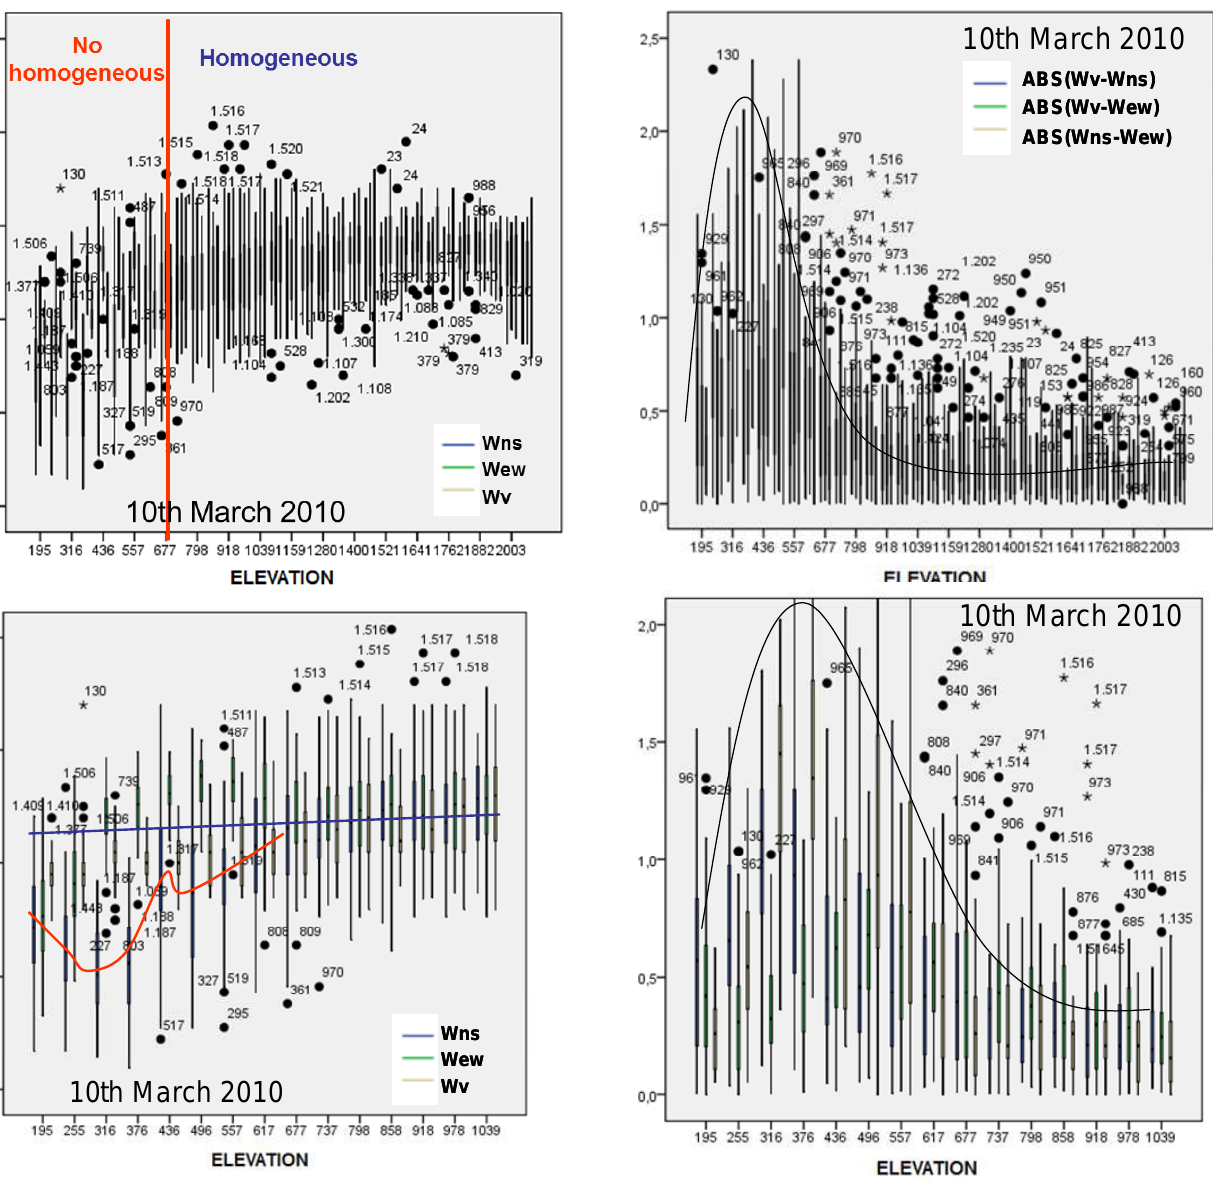
Fig. 9. North pattern: box plots of the absolute values of differences between velocities on 10 March 2010. (top) Differences between velocities up to a height of 2000m. x axis (height in ma.s.l.). y axis (velocity in ms − 1 ) . Black line represents the envelope curve of the 3rd quartile. (bottom) Zoom for the first kilometre. x axis (height in ma.s.l.). y axis (velocity in ms − 1 )